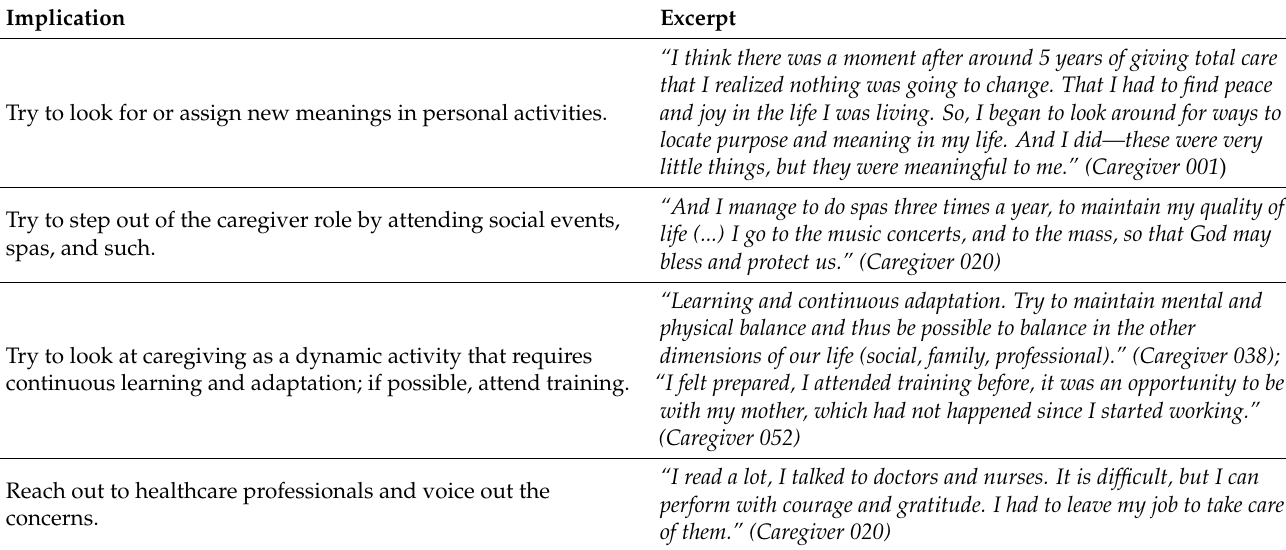
Table 6. Practical implications to the family caregiver.